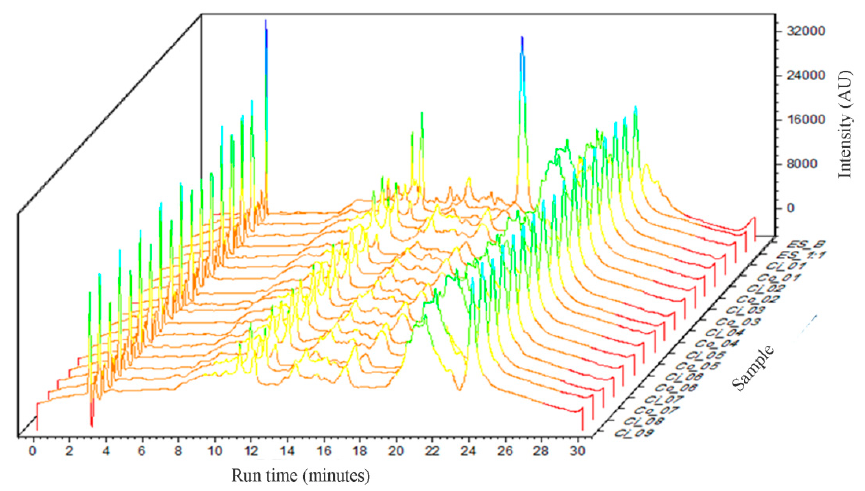
Figure 2. Overlap of chromatographic profiles of the obtained dried extracts.